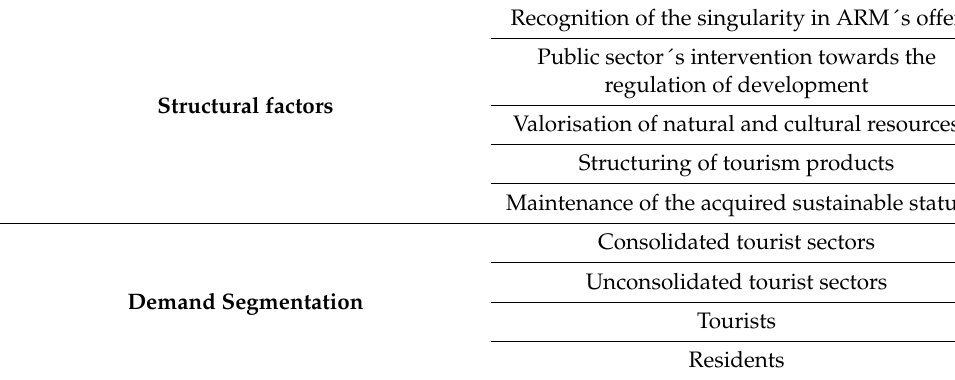
Table 4. Systematization of the development